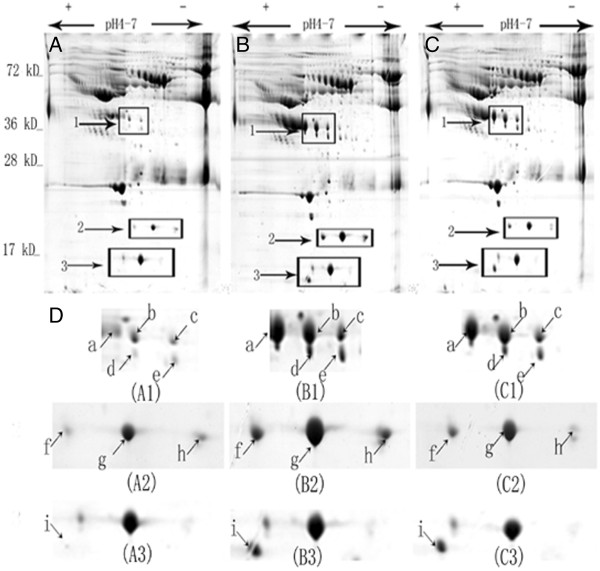
Differentially expressed protein spots identified by 2-DE image analysis. The original 2-DE images representing all protein spots present in serum samples from the nonresponder group (A), the responder group (B), and the healthy control group (C). The enlarged images (D) showing the magnified regions 1–3 of the corresponding 2-DE gels. Nine identified protein spots (a-i, arrows showing the corresponding locations) with significantly differential expressions among the three groups were visualised. Protein spots a to i showed obviously decreased expressions in the nonresponders compared with the responders and healthy controls.